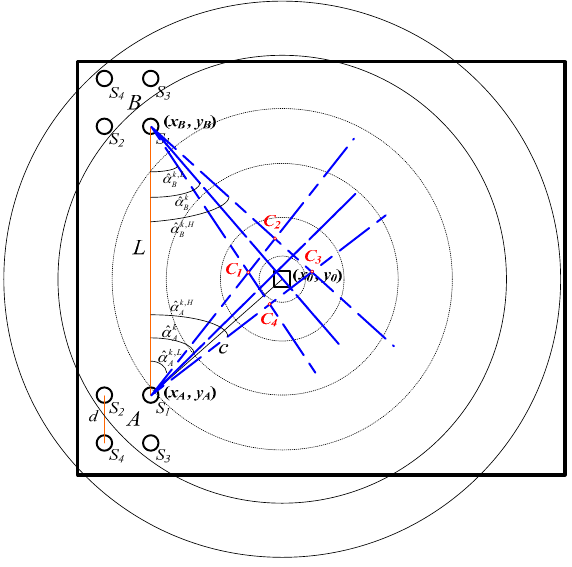
Figure 2. The fire source arrangement localization principle in the RRR frame.